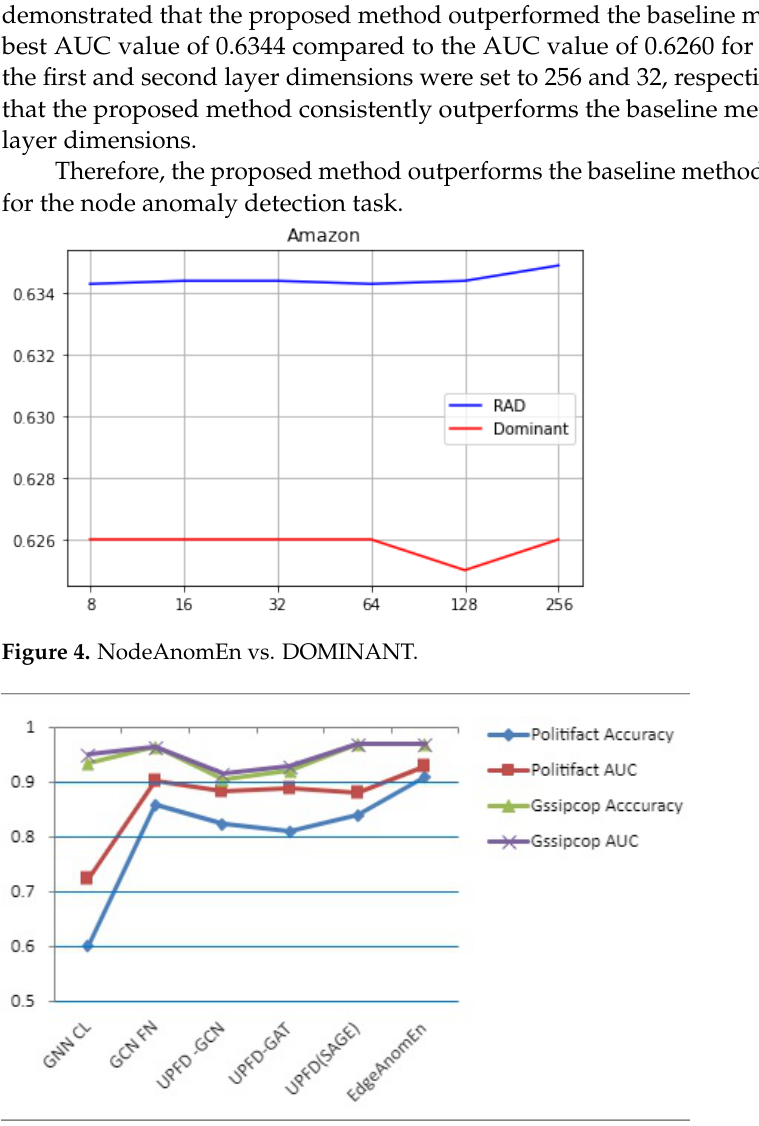
Figure 5. Comparison of base methods and proposed method EdgeAnomEn in terms of accuracy and AUC for edge anomaly detection on PolitiFact and GossipCop datasets. The figure displays the performance trend of the different methods, with higher values indicating better